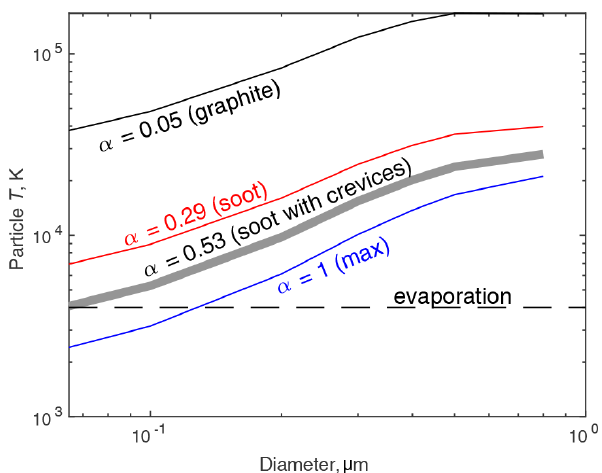
Figure 5. Effect of the accommodation coefficient α on calculated heating of model soot aerosol in the UHSAS. Once the particle reaches the evaporation temperature of soot, roughly 4000K, it will cease heating up and will evaporate until small enough that heating balances conductive